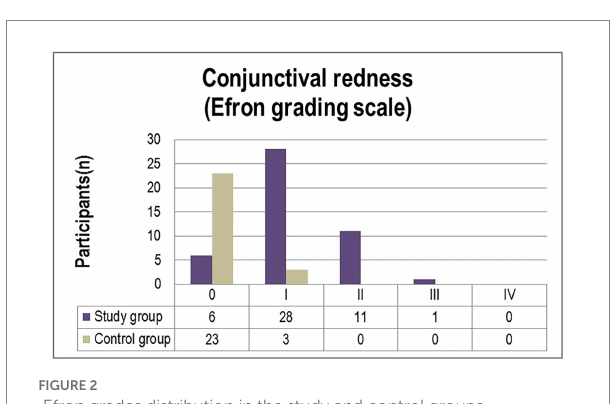
FIGURE 2 Efron grades distribution in the study and control